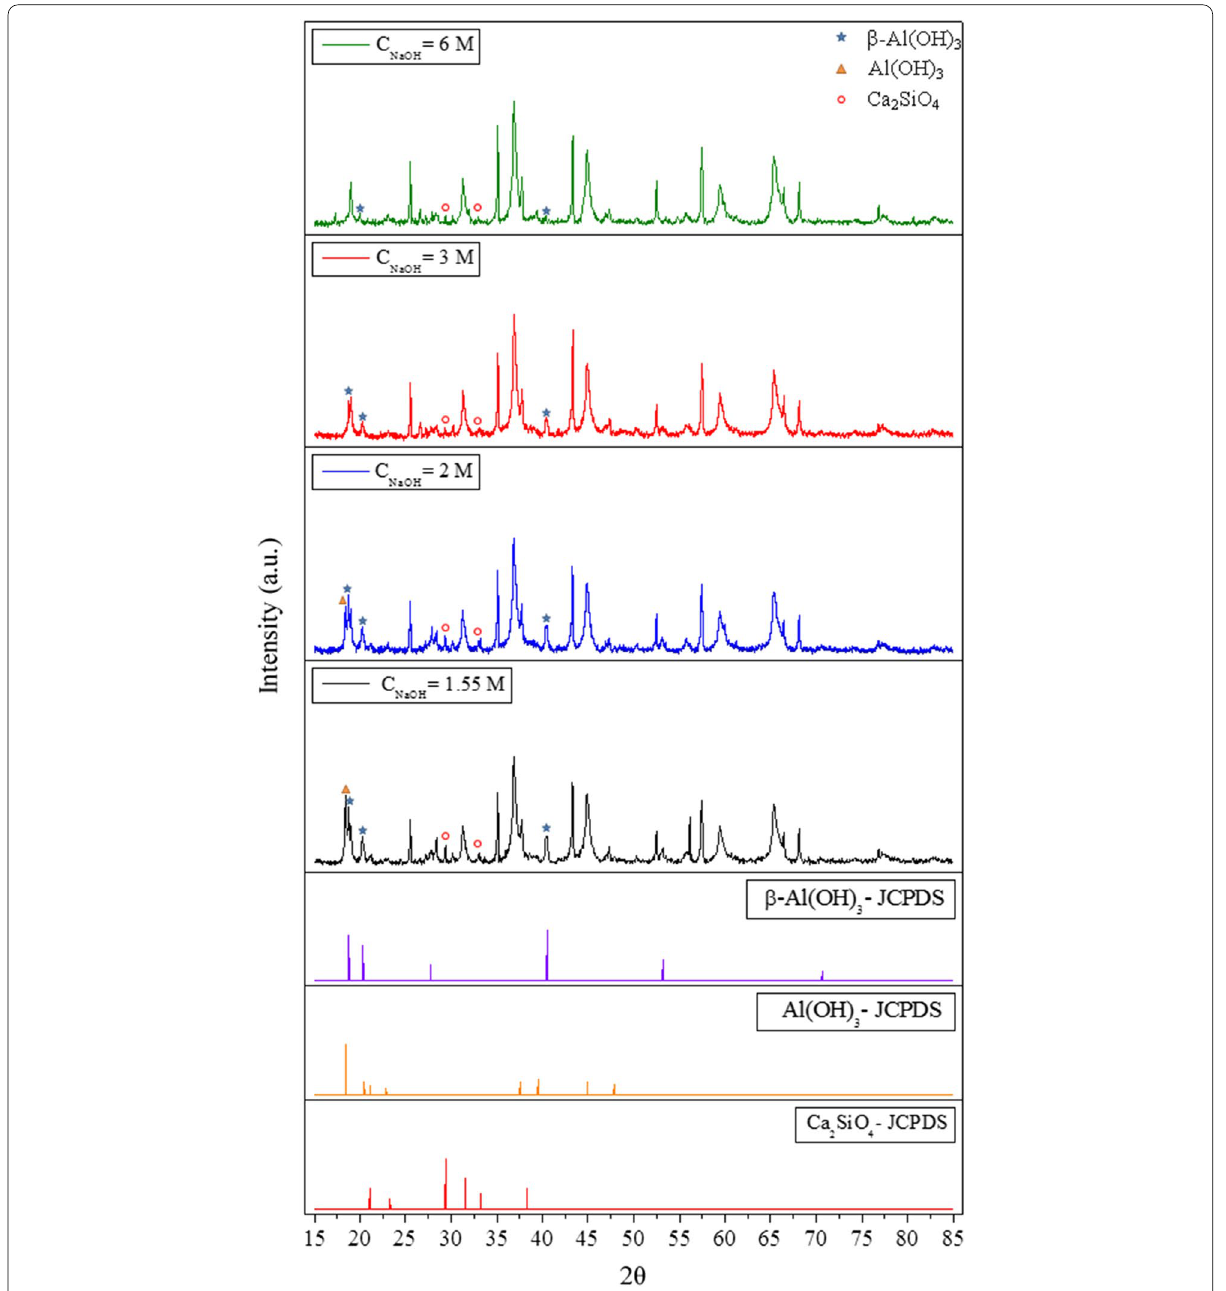
Fig. 7 XRD pattern of SAD residue after under different C NaOH (reacted at 50 °C, 60